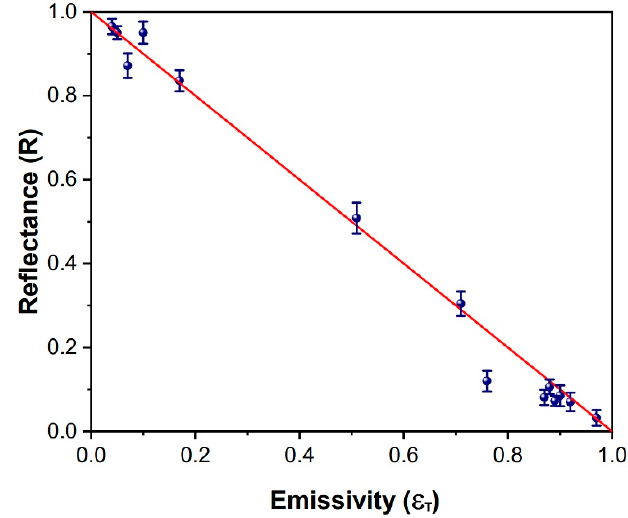
Figure 4. Plot comparing the ( R , ε T ) data of Table 1 and the expected linear dependence R = 1 − ε .